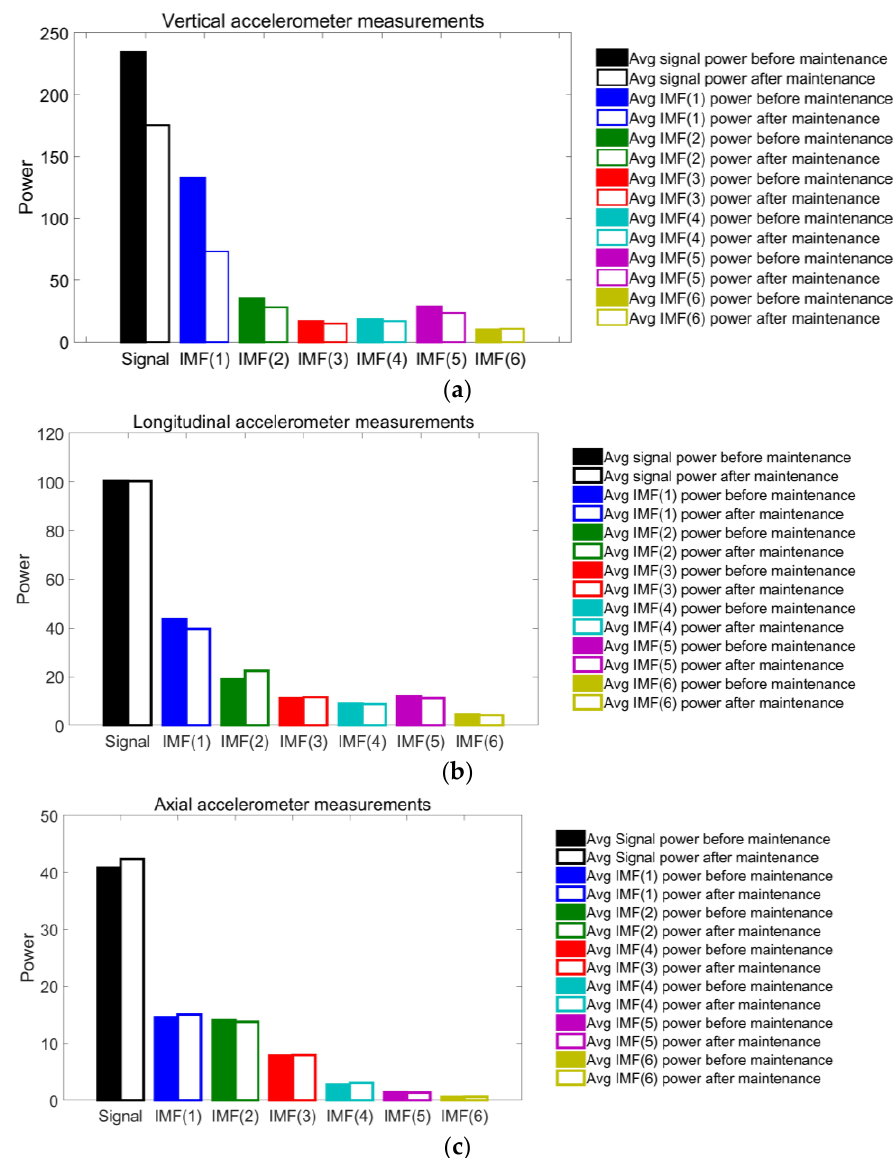
Figure 12. The average spectral power values of the signal and the IMF of ( a ) the vertical; ( b ) the longitudinal, and ( c ) the axial vibrations before (filled bars) and after (blank bars) wheel intervention.